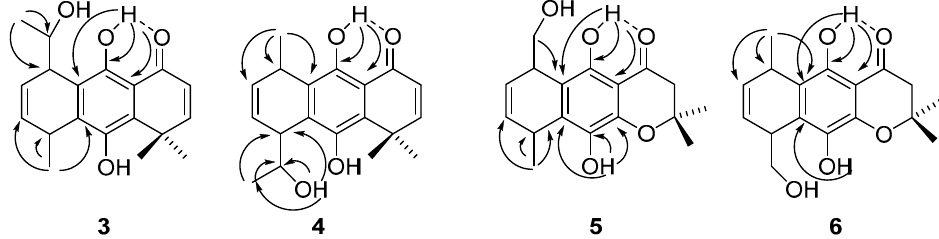
Figure 2. Key HMBC long-range correlations used for structural assignments of regioisomeric compounds.